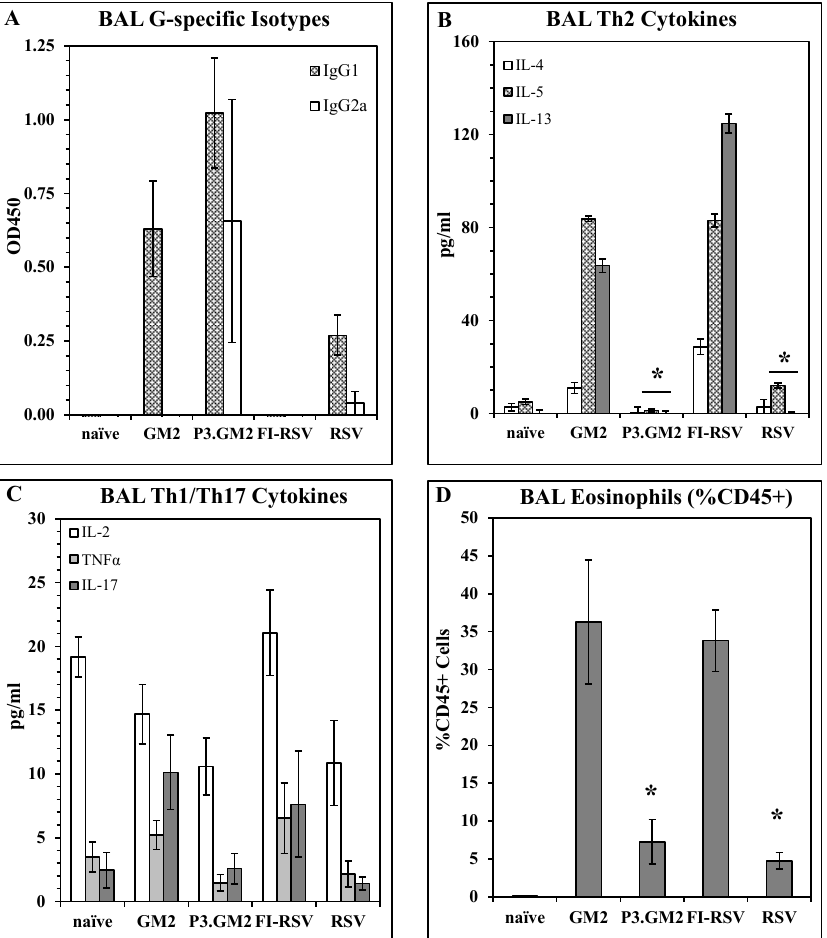
Figure 4. Influence of TLR2 engagement on post-challenge Th2 and eosinophil response. BALB/c mice were immunized on days 0 and 21 as indicated (day 0 only for live RSV), challenged with live RSV on day 35, and sacrificed on day 41 for harvesting of BAL fluid and cells. All analyses were conducted on day 41 (day 6 post-challenge) BAL samples. ( A ) BAL RSV G-specific antibody isotype levels measured by ELISA. Mean ± SEM of 6 mice per group at 1:5 BAL dilution. ( B ) Th2 cytokine content of BAL fluids measured by Luminex. Mean ± SEM of 6 mice per group. * p < 0.05 vs. GM2 and FI-RSV groups for IL-5 and IL-13. ( C ) Th1/Th17 cytokine content of BAL fluids measured by per group. * p < 0.05 vs. GM2 and FI-RSV